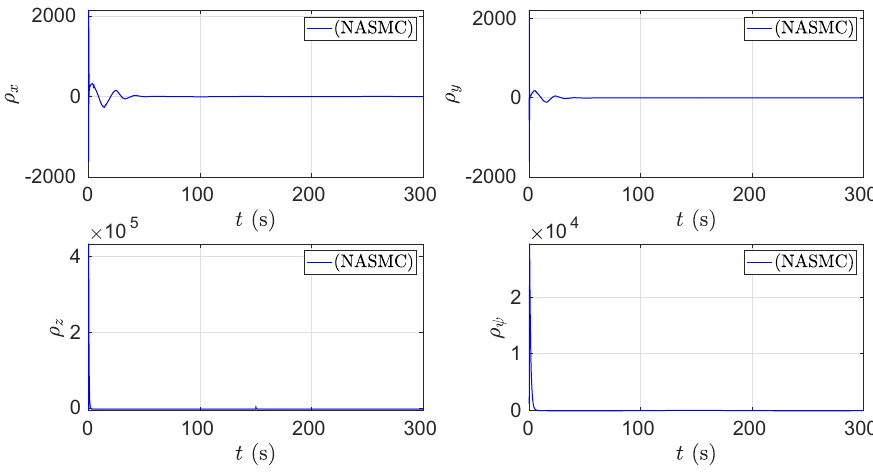
Figure 9: Residual errors of quadcopter simulation using